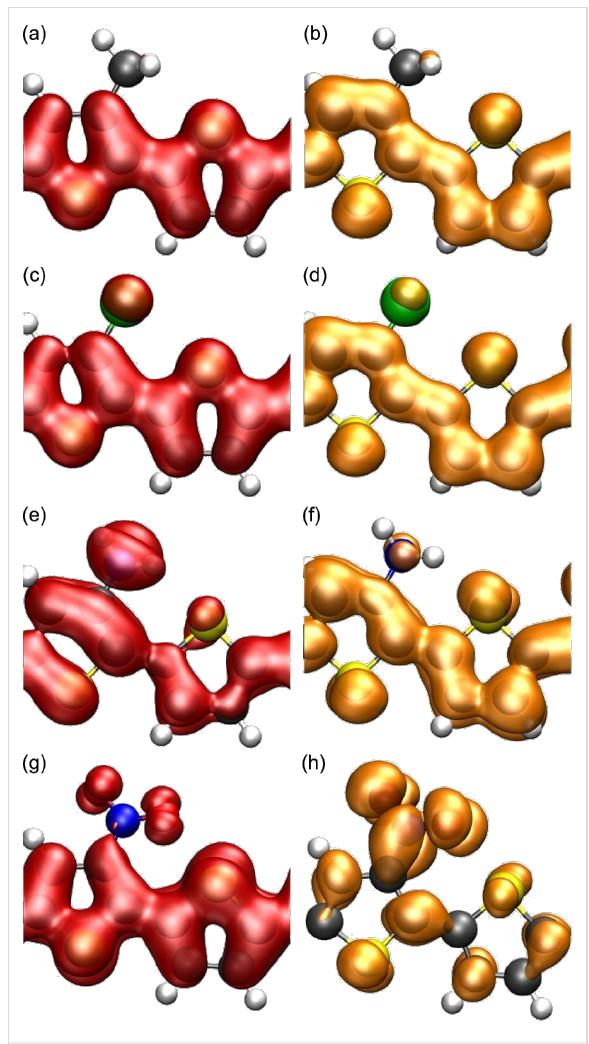
Figure 7: Electronic density isosurfaces ( ρ ( r ) = 0 . 01 e/ Å 3 ) of the HOCO (red) and LUCO (orange) for (a), (b) CH 3 PTp; (c), (d) ClPTp; (e), (f) NH 2 PTp; (g), (h) NO 2 PTp.